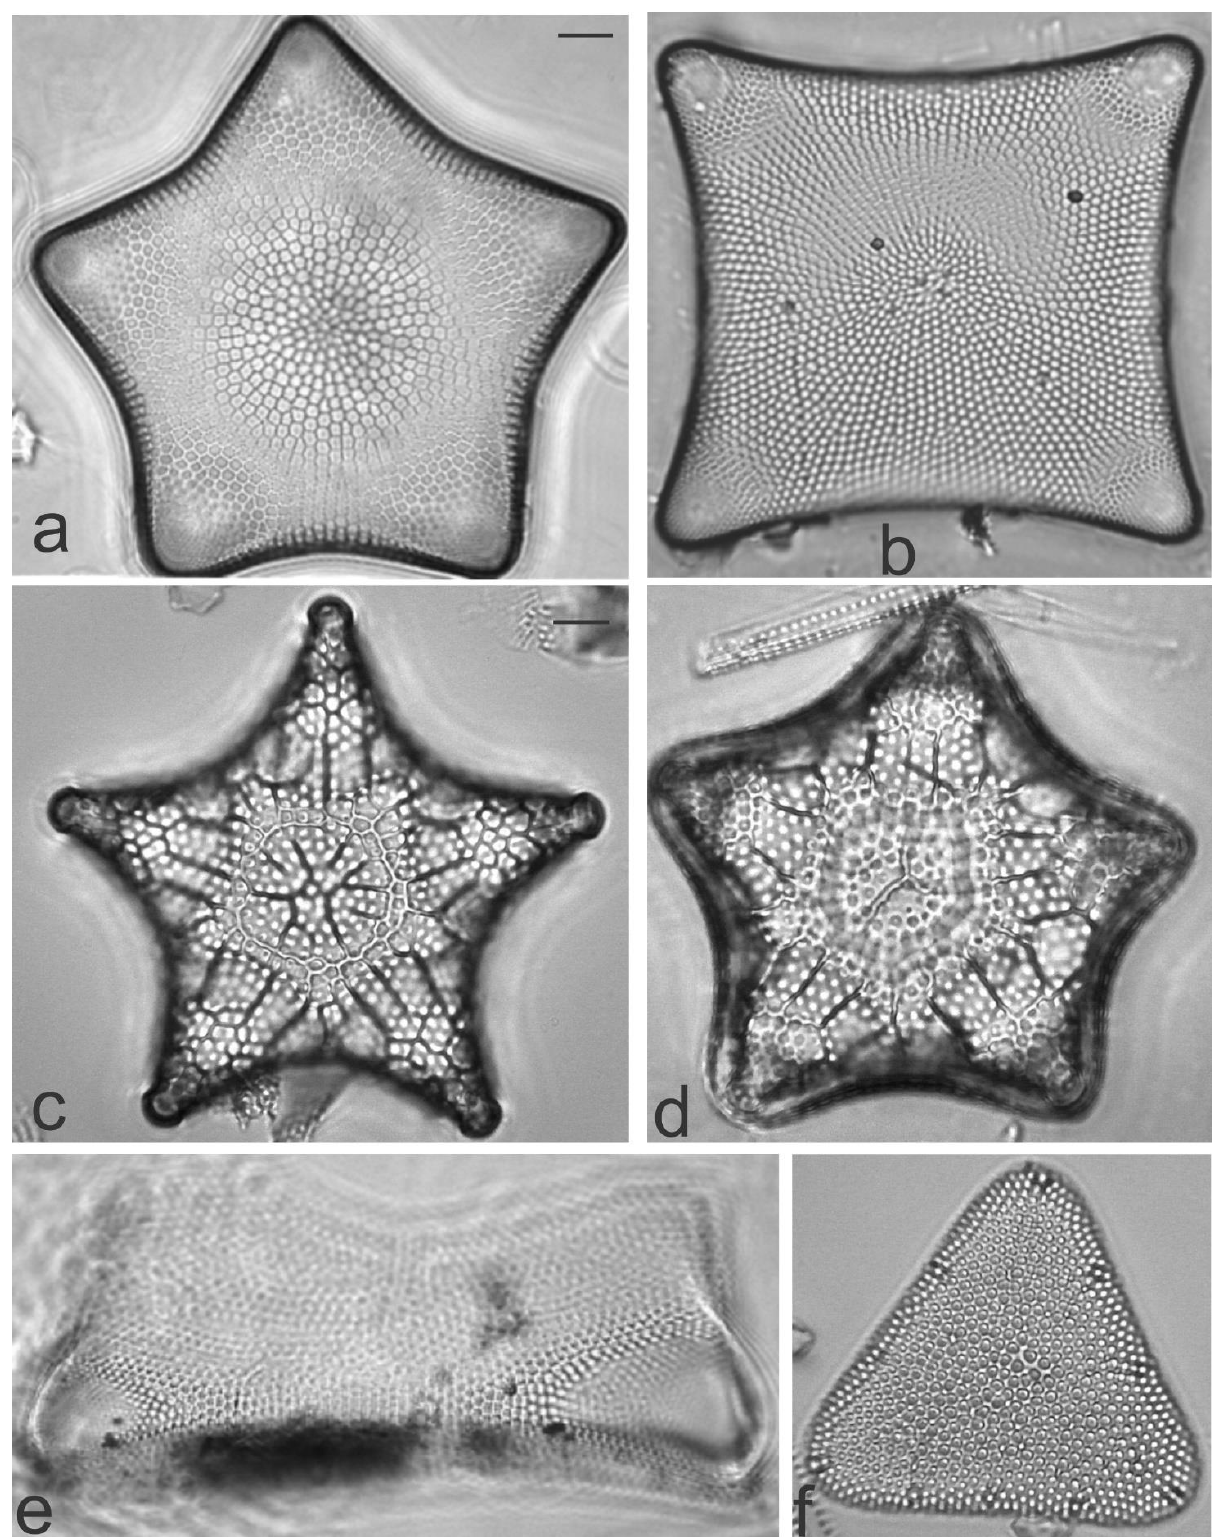
Figure 2. ( a ) Triceratium formosum var. quinquelobatum ; ( b ) Trigonium diaphanum ; ( c , d ) Triceratium biquadratum ; ( e ) Trigonium formosum f. quadrangularis ; ( f ) Pseudotriceratium punctatum . Scale bars: ( a – d , f ) = 10 μm, ( e ) = 15 μm.